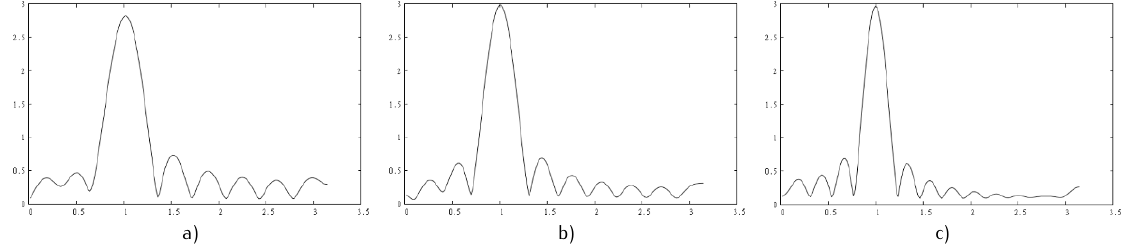
Figure 1. The modulus of the function p N ( x ) for the case when q ( x ) has the form (12) : a) corresponds to N = 17 , b) corresponds to N = 19 , c) corresponds to N = 26 .